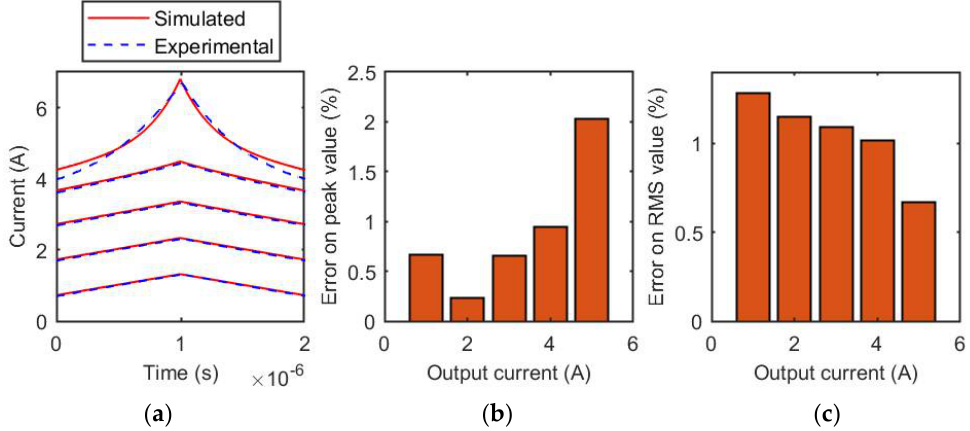
Figure 11. Coilcraft MSS1260T-273 inductor, 32 V. ( a ) Comparison of experimental and simulated current waveforms for different output current values; ( b ) relative error of the estimation of the peak value of the inductive current; ( c ) relative error of the estimation of the RMS value of the inductive current.